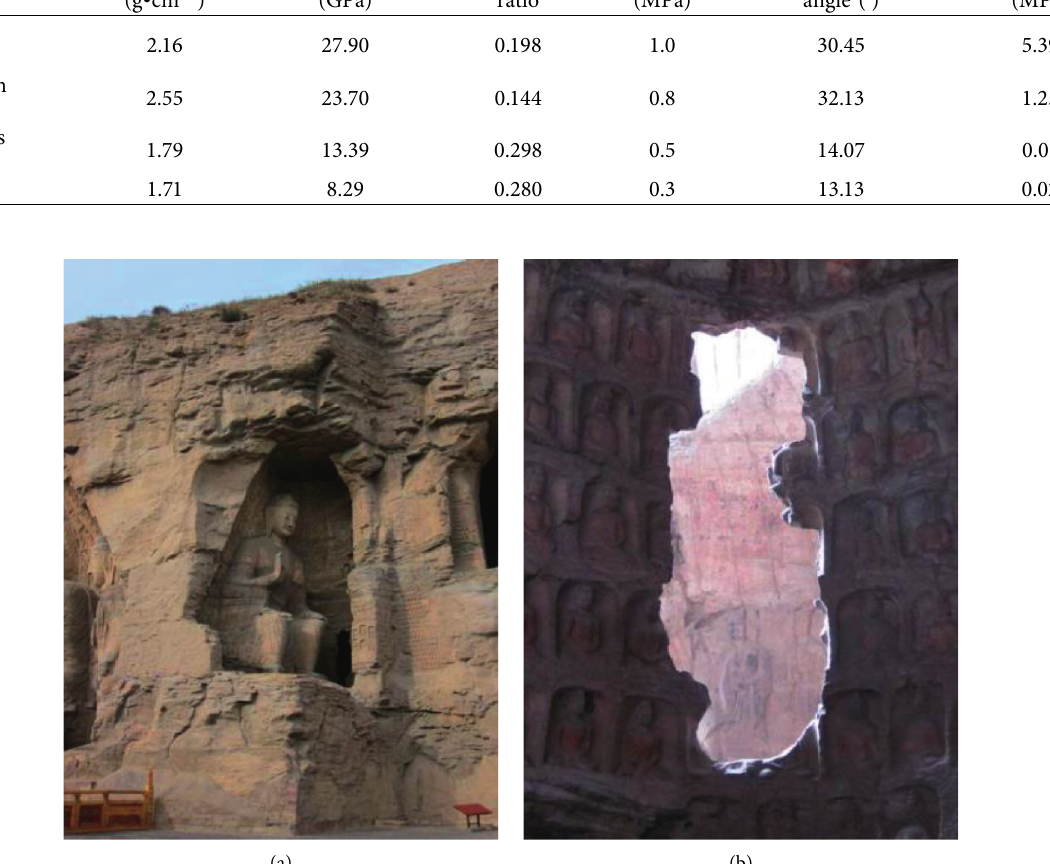
Figure 3: (a) Western ear grotto of the 19th grotto in Yungang. (b) Damage to the thin wall between the ear grotto and the main grotto.